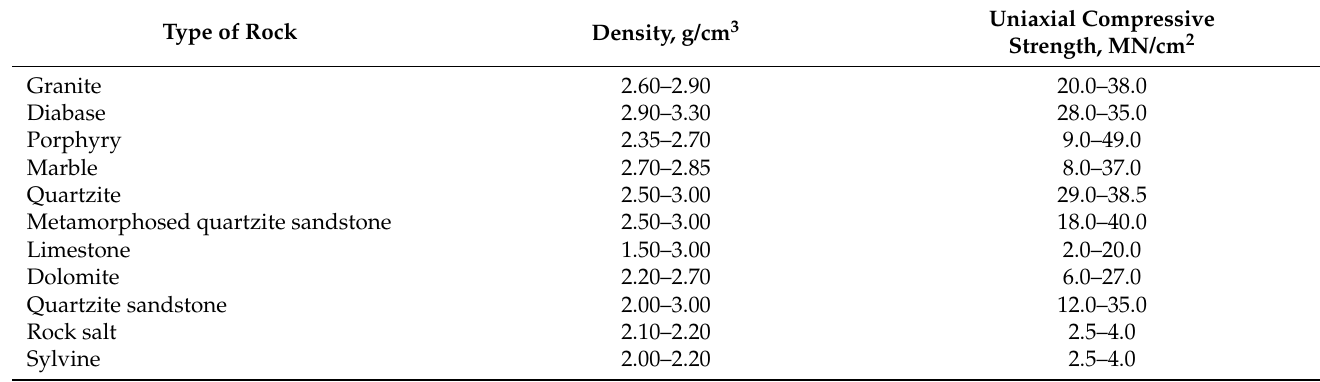
Table 1. Physicochemical properties of rocks (according to [47]).